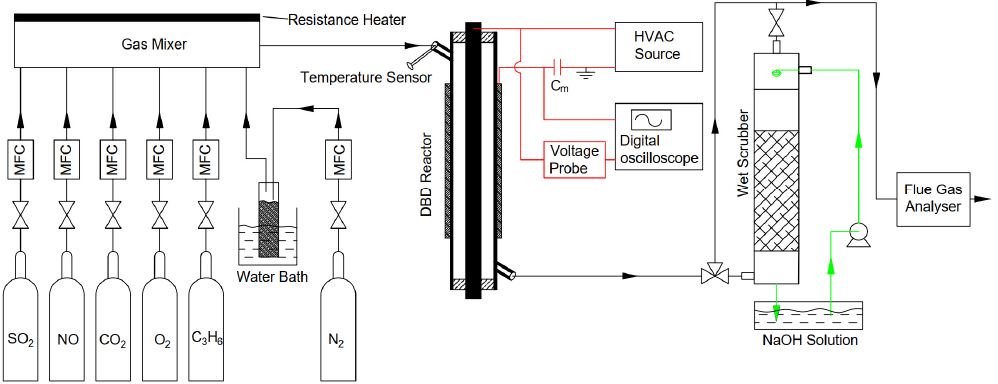
Figure 2. The schematic diagram of the experimental